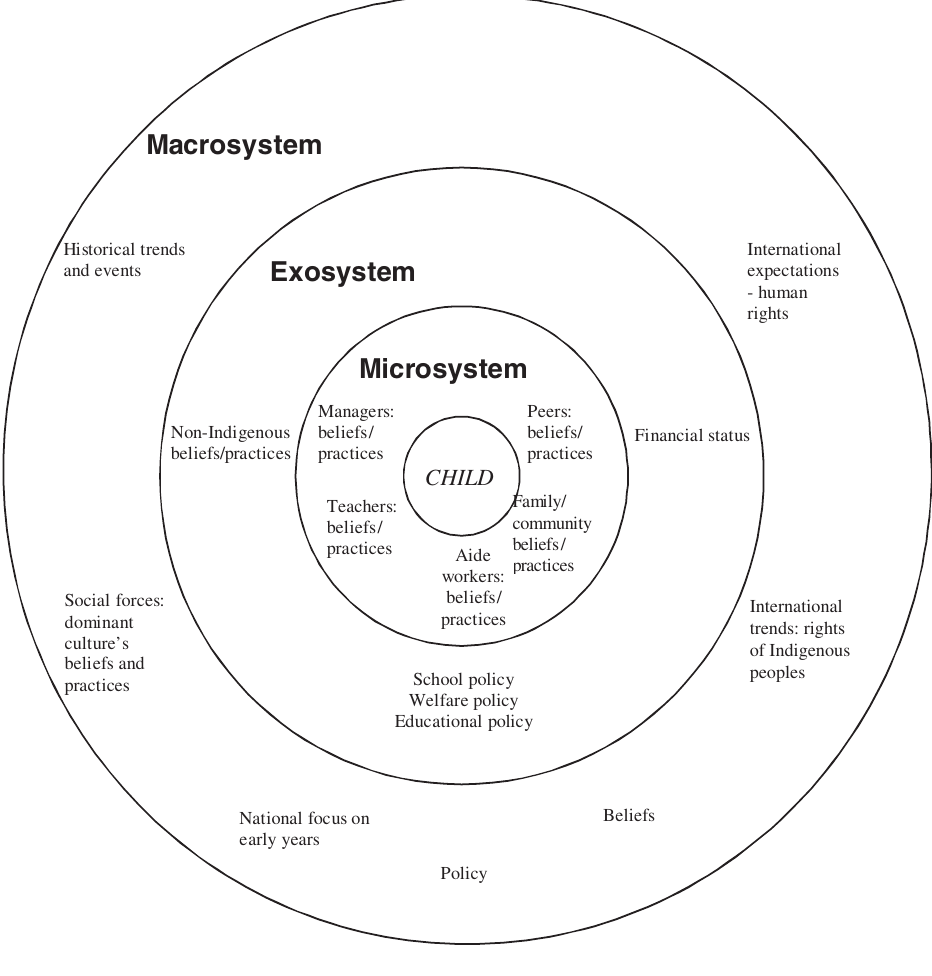
Figure 1 The bio-ecological